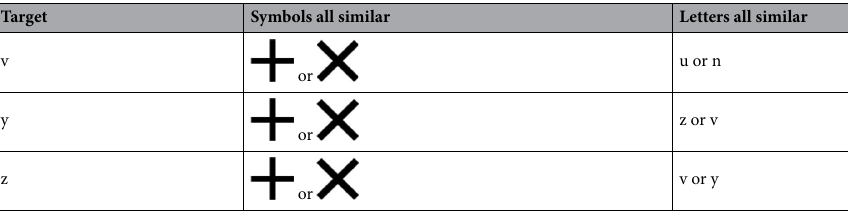
Table 1. Visual distracters (symbols or letters, all similar or all different) used for each target